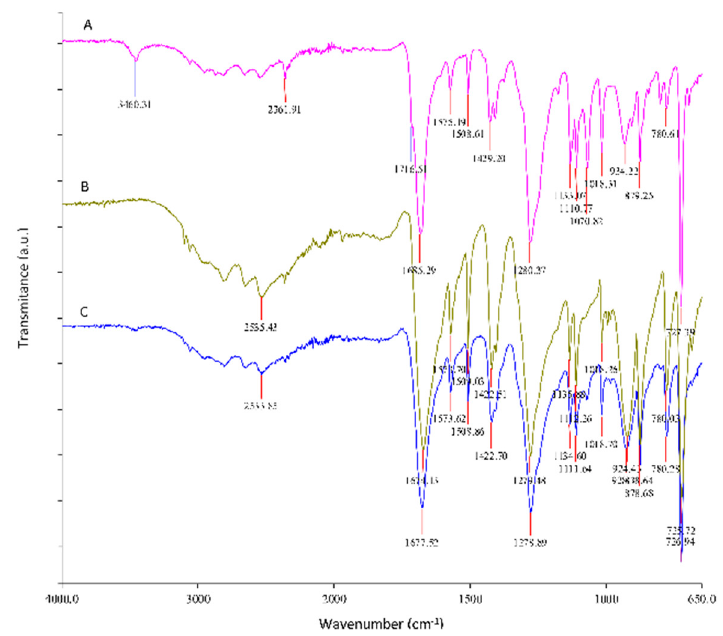
Figure 6. ATR–FTIR spectra of commercially available pure TPA (B–green spectrum), isolated solid fraction after neutral hydrolysis of PET foil (C—blue spectrum), and isolated solid fraction after neutral hydrolysis of PET foil coated with chitosan (A—pink spectrum).